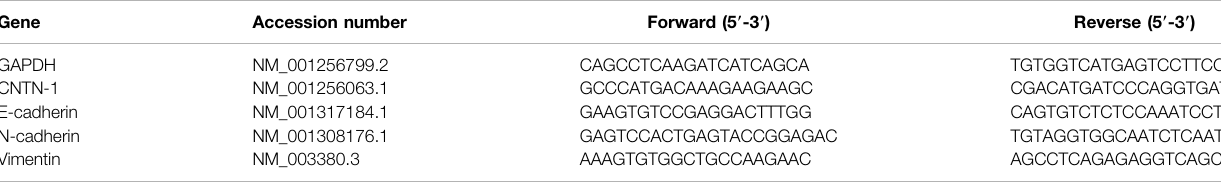
TABLE 1 | Primers of target